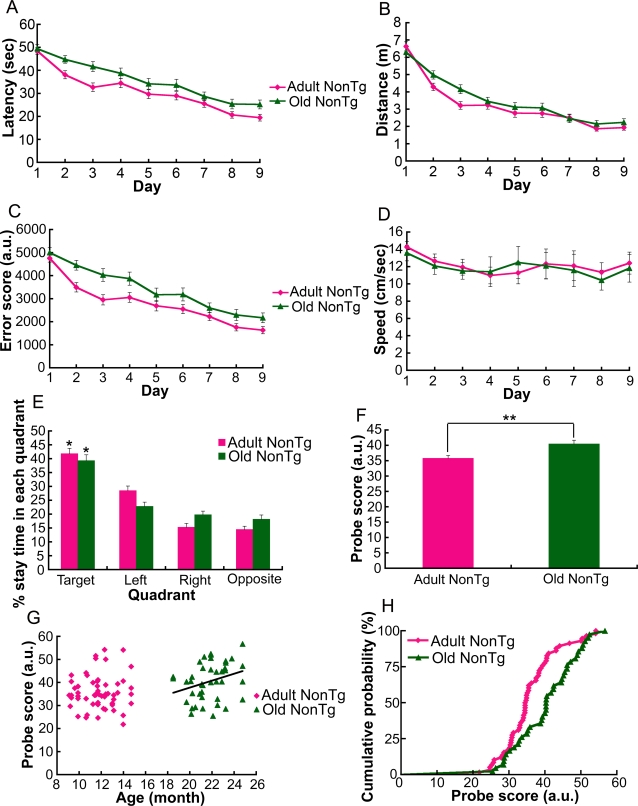
Age-dependent delay in learning and reduced accuracy of memory in wild-type mice.(A) Old nonTg mice took significantly longer than adult nonTg mice to reach the hidden platform (F[1,98] = 5.74, p = 0.0167; repeated measures two-way ANOVA). (B) There was no statistical difference in the distances swam by mice of the two age groups. (C) The error scores of old nonTg mice were significantly higher than those of adult nonTg mice (F[1,98] = 11.42, p = 0.0008; repeated measures two-way ANOVA). (D) The swimming speed of mice of the two age groups was not significantly different. (E) Both adult and old nonTg mice displayed a place preference for the target quadrant in the probe test (both age groups, *p<0.0001; Friedman test). There was no statistical difference in the percentage dwell time in the target quadrant of adult and old nonTg mice. (F) However, the probe scores of the old nonTg mice were significantly higher than those of adult nonTg mice (**p = 0.0038; two-tailed Mann-Whitney U test), indicating that the memory of old nonTg mice was less accurate than that of adult nonTg mice. In terms of both percentage of target-quadrant dwell time and probe score, there was no significant difference between the small cohorts of nonTg mice from the single mouse line used in experiments for Figure 1 and the large cohorts from multiple lines used here at each age group. A significant difference in probe score between the large cohort of adult nonTg mice (n = 58) and the small cohort of adult APP/PS1 mice (n = 14) was ascertained (p = 0.0059; two-tailed Mann-Whitney U test). (G) There was a significant correlation between age and probe score within the old nonTg mouse group (p = 0.0455; two-tailed Spearman test) but not within the adult nonTg mouse group. No correlation was observed among the adult APP/PS1 mice used for the experiments of Figure 1. (H) In the cumulative probability plot, there was also a significant difference in the distribution of probe scores of nonTg mice for two age groups (p = 0.0095; two-sample Kolmogorov-Smirnov test). Mice used in these experiments were nonTg controls from a variety of transgenic lines with a common C57BL/6J background strain. We used 58 adult mice (9–15 months, 11.7±1.6 months) and 42 old mice (19–25 months, 21.8±1.6 months).